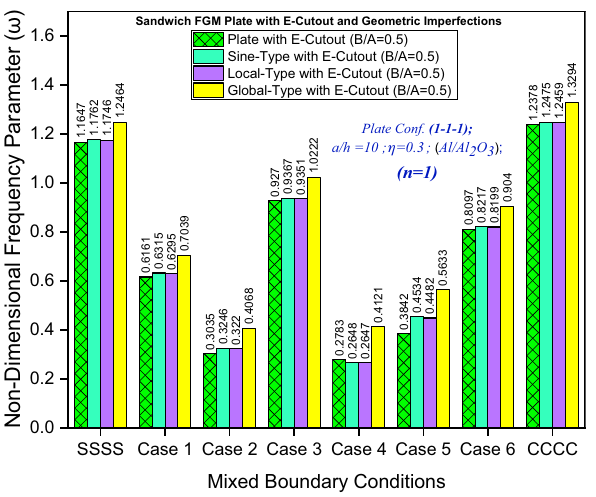
Figure 20: E ff ect of conventional and unconventional ( mixed ) boundary conditions on the NDFP of SFGM plate with elliptical cutout along with various imperfections using ( 1 - 1 - 1 ) con fi